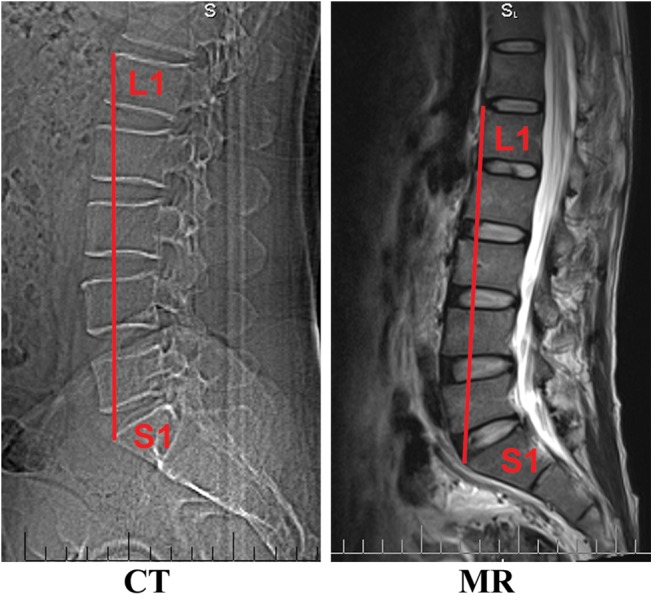
Measurements of the height lumbar vertebrae.The height of lumbar vertebrae was measured by the straight-line distance between the anterior superior border of the L1 vertebra and the anterior superior border of the S1 vertebra (promontory).